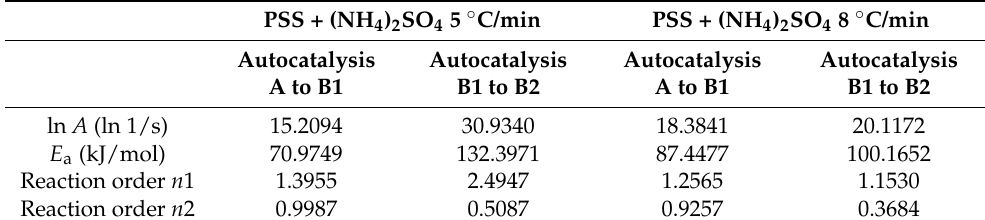
Table 6. Thermokinetic evaluation of the multistage reaction models of PSS + (NH 4 ) 2 SO 4 .